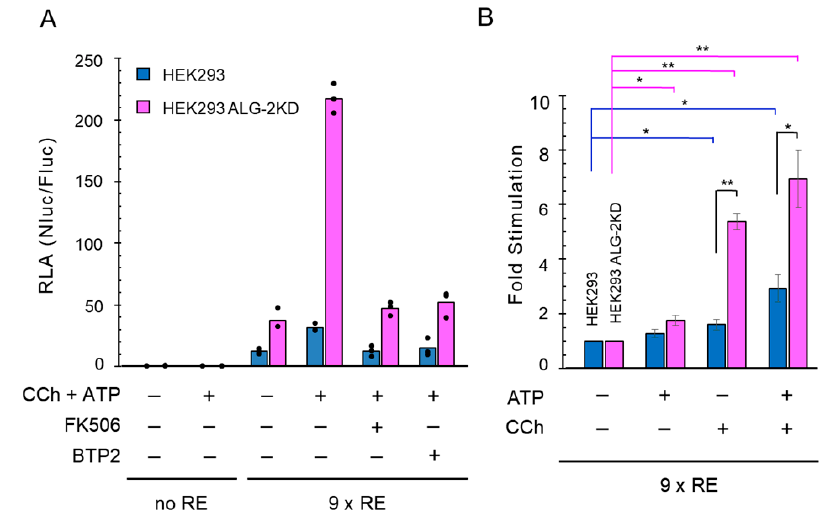
Figure 4. A higher NFAT activation by carbachol stimulation in the ALG-2KD cells than the parental HEK293 cells. ( A ) NFAT reporter assays were performed in triplicates using the 9 × IL8 NFAT-RE NanoLuc reporter by concomitant stimulation with carbachol (CCh, 100 µ M; vehicle, medium) and ATP (100 µ M; vehicle, medium) for 6 h with or without pre-treatment with FK506 (10 µ M) or BTP2 (1 µ M) for 1 h. Dots and bars represent individual and averaged values obtained from triplicate assays, respectively. The presence and absence of the reagents are indicated by + and − , respectively. ( B ) The NFAT reporter assays in triplicates were performed as in ( A ) by stimulation with ATP (100 µ M) and carbachol (CCh, 100 µ M) separately or concomitantly. Independent experiments in triplicates were performed three times under the same conditions. Fold stimulation represents the ratio of RLA values obtained by stimulation to those obtained without stimulation (the resting condition) and is presented as mean ± SEM ( n = 3). Statistical significance by Tukey’s test is indicated by asterisks (*, p < 0.05; **, p <